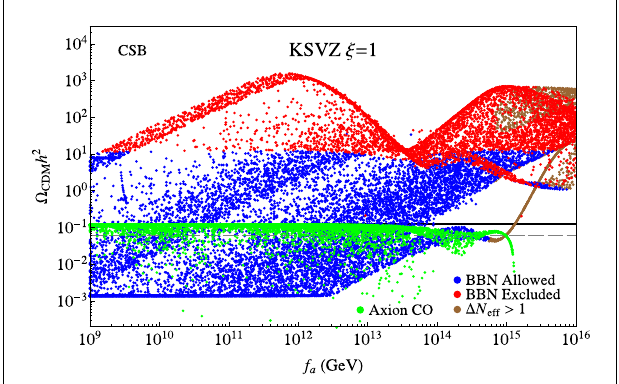
FIGURE 4 | The wino-like WIMP and axion relic densities from a scan over SUSY DFSZ parameter space for the CSB benchmark case with ξ = 0 . The gray dashed line shows the points where DM consists of 50% axions and 50%